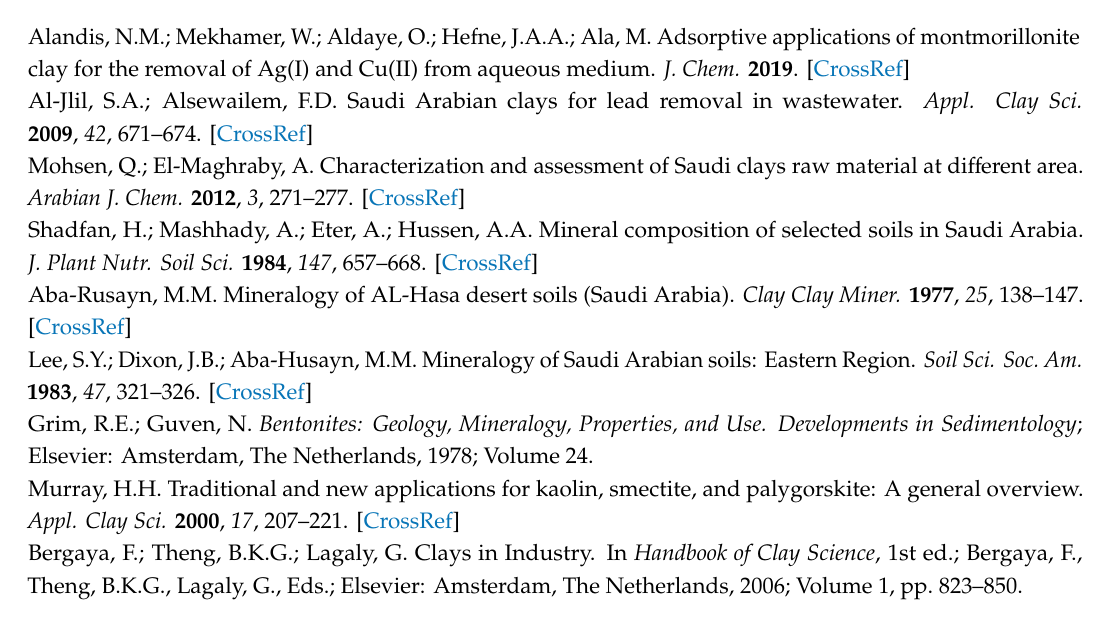
Figure S1: Localization of Al-Hasa oasis in Saudi Arabia, Figure S2: Localization of in the study clays soil-sites in Al-Hasa oasis, Figure S3: Typical titration curves of 25 mL 0.004 mol L − 1 HCl + 25 m L 0.02 mol L − 1 KCl. Titration with 0.042 mol L − 1 KOH in the absence ( (cid:3) , curve) and in the presence ( (cid:4) , curve) of clay (a) C1, Figure S4: Typical titration curves of 25 mL 0.004 mol L − 1 HCl + 25 m L 0.02 mol L − 1 KCl. Titration with 0.042 mol L − 1 KOH in the absence ( (cid:3) , curve) and in the presence ( (cid:4) , curve) of clay (b) C2. Figure S5: Typical titration curves of 25 mL 0.004 mol L − 1 HCl + 25 m L 0.02 mol L − 1 KCl. Titration with 0.042 mol L − 1 KOH in the absence ( (cid:3) , curve) and in the presence ( (cid:4) , curve) of clay (c) C3. Figure S6: Typical titration curves of 25 mL 0.004 mol L − 1 HCl + 25 m L 0.02 mol L − 1 KCl. Titration with 0.042 mol L − 1 KOH in the absence ( (cid:3) , curve) and in the presence ( (cid:4) , curve) of clay (d) C4, Figure S7: Typical titration curves of 25 mL 0.004 mol L − 1 HCl + 25 m L 0.02 mol L − 1 KCl. Titration with 0.042 mol L − 1 KOH in the absence ( (cid:3) , curve) and in the presence ( (cid:4) , curve) of clay (e) C5. Figure S8. Catalytic performances (conversion (%) and selectivity (%)) of acid-activated clays understudy in methanol dehydration (ethylene (C2 = ), propylene (C3 = ), formaldehyde (HCHO), dimethyether (DME) and carbon dioxide